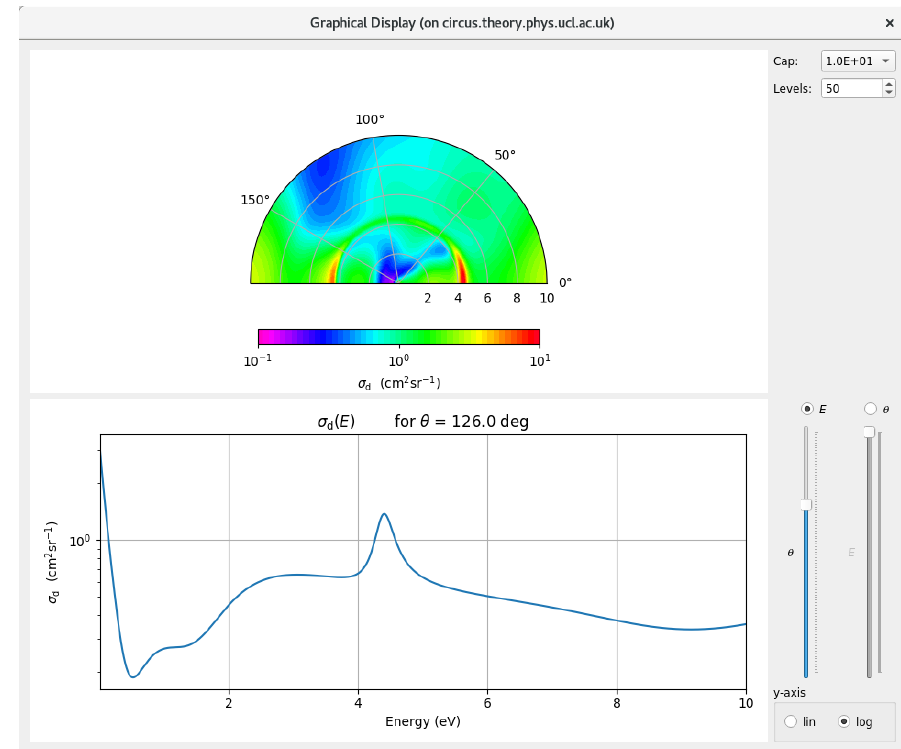
Figure 6. Differential cross sections for CO 2 as displayed by the QEC GUI.